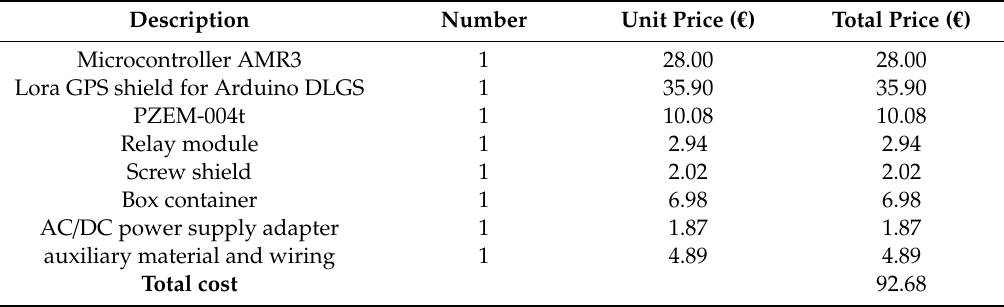
Table 3. IMEMSL with GPS cost.